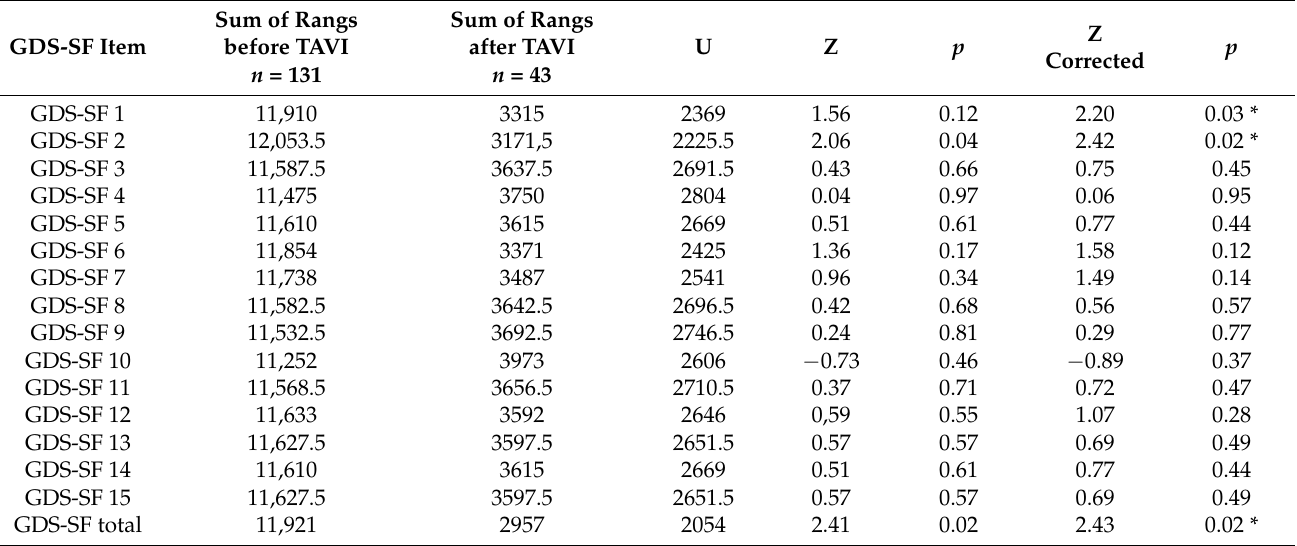
Table 2. The results regarding emotional functioning before and after TAVI (Mann–Whitney U -test, * p <